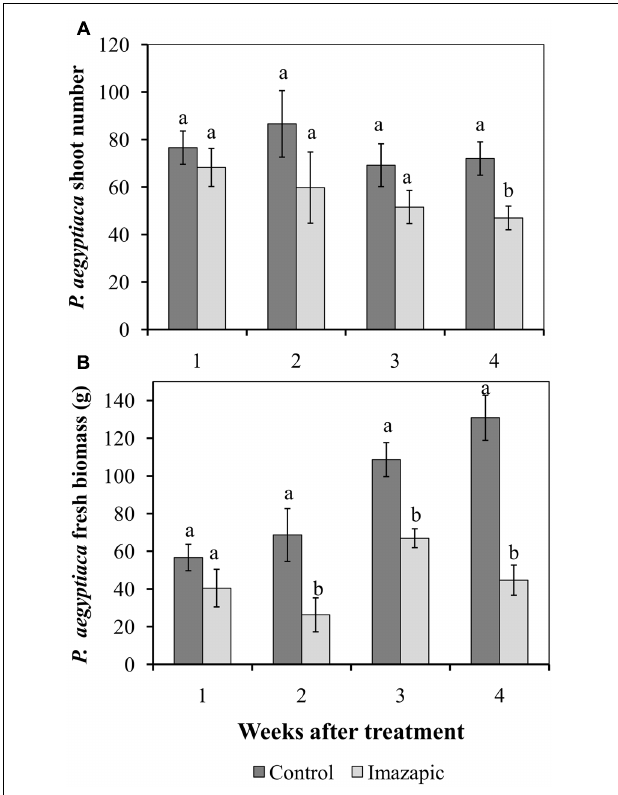
FIGURE 3 | Effect of imazapic (38.4 g a.i. ha − 1 ) applied at 277 growing degree days on the number (A) and biomass (B) of P. aegyptiaca flowering shoots attached to the roots of HRT tomato plants. Non-treated plants were used as controls. Data were recorded once a week, starting 1 week after treatment for 4 weeks. The experiment was repeated twice with 10 replicates. Results of the two experiments were compared by Fisher’s t -test and data were combined due to homogeneity of the variances. Results were subjected to ANOVA. Data were compared by least-significant differences (LSD), on the basis of Tukey–Kramer Honestly Significant Difference test ( α = 0.05). Different letters indicate significant differences between various treatments on the same observation date. Vertical lines indicate standard errors of means